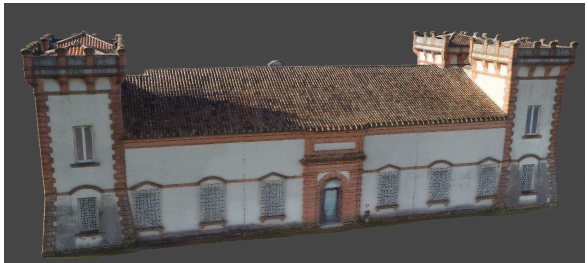
Figure 32: Back view of the textured model of the castle.